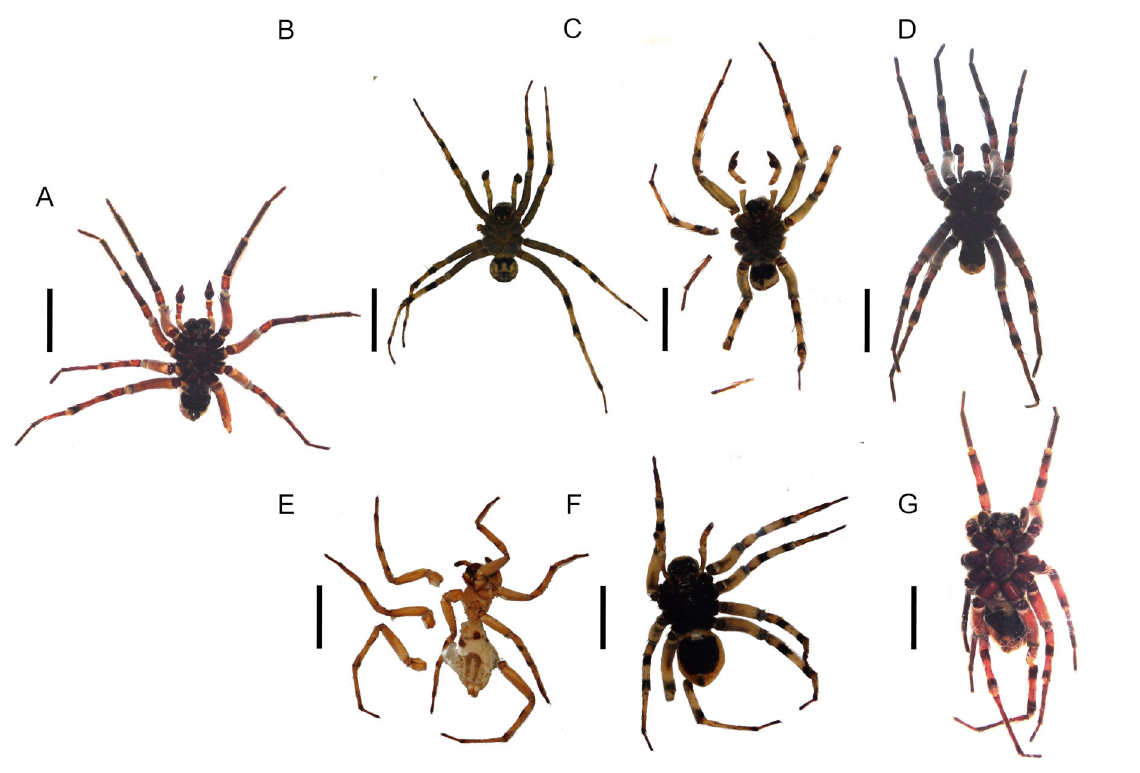
Fig. 7. Habitus, ventral view. A . Geolycosa vultuosa C.L. Koch, 1838, ♂ (HUJ INV-AR20961). B . Lycosa gesserit sp. nov . , holotype, ♂ (HUJ INV-AR20631). C . Lycosa hyraculus sp. nov . , holotype, ♂ (HUJ INV-AR20818) . D . Lycosa piochardi Simon, 1876, ♂ (HUJ INV-AR20597). E . Lycosa sp . , ♀ (HUJ INV-AR20573). F . Lycosa hyraculus sp. nov . , paratype, ♀ (HUJ INV-AR20817). G . Lycosa piochardi Simon, 1876, ♀ (SMFD11934). Scale bars = 10 mm. Photos by I. Armiach